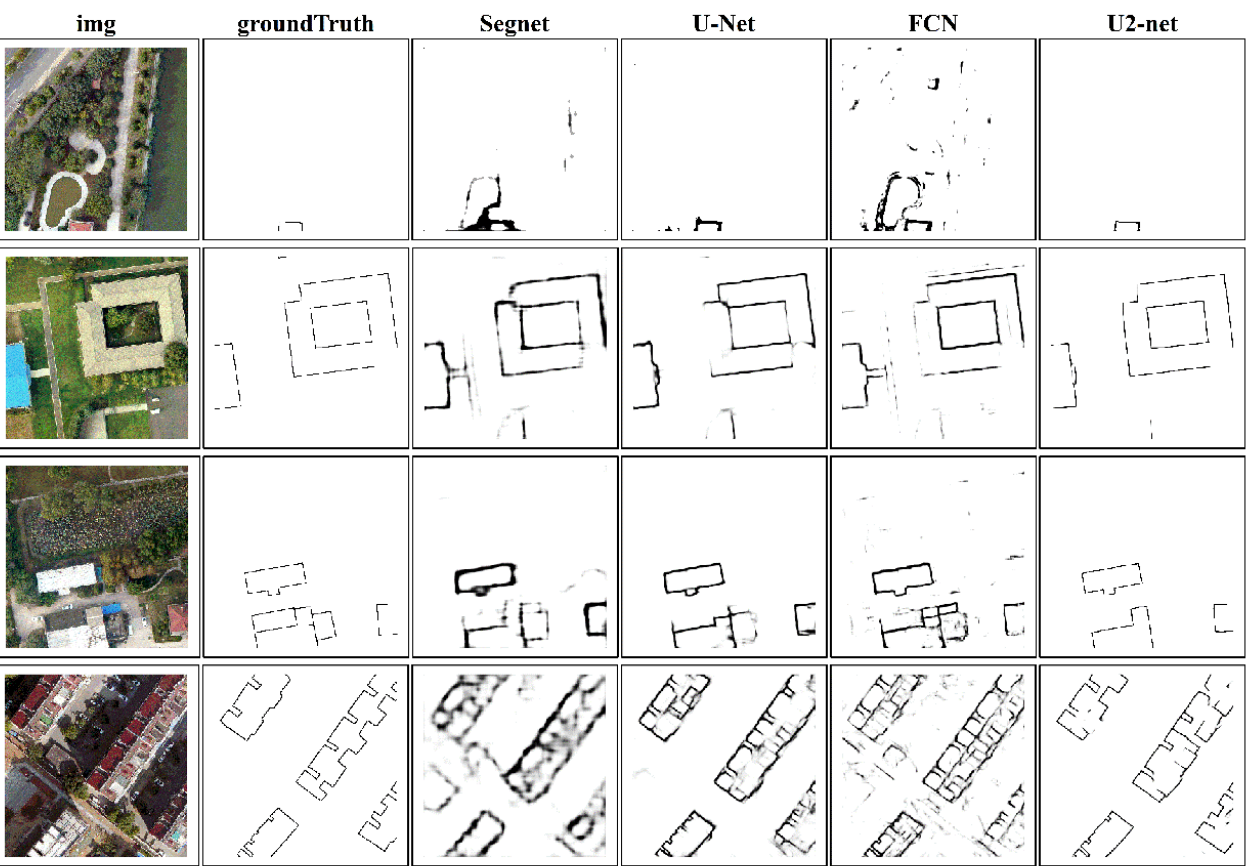
Figure 6. Visual comparison of different semantic segmentation models on Nanjing dataset.